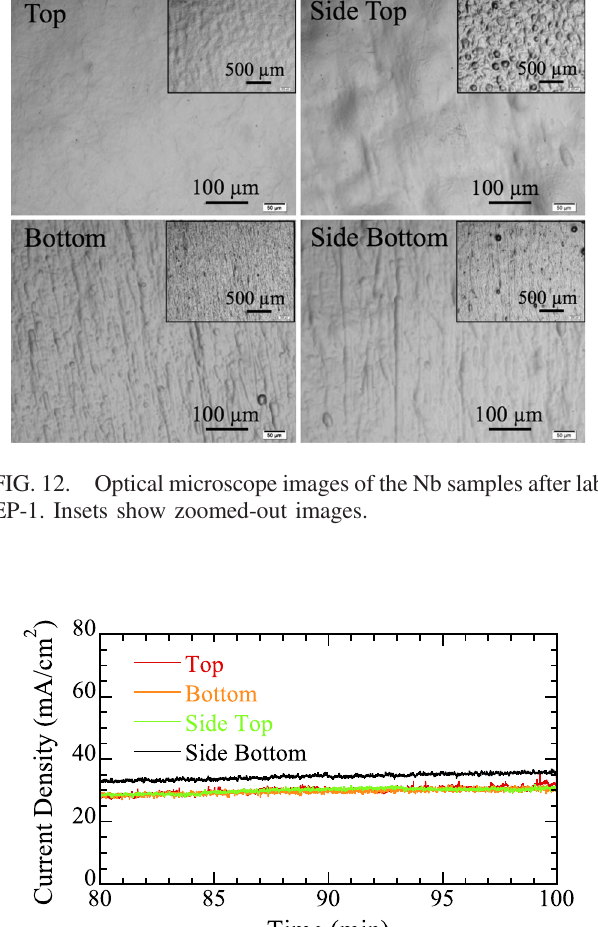
FIG. 13. Current densities for the Nb samples at a stirring speed of 210 rpm.